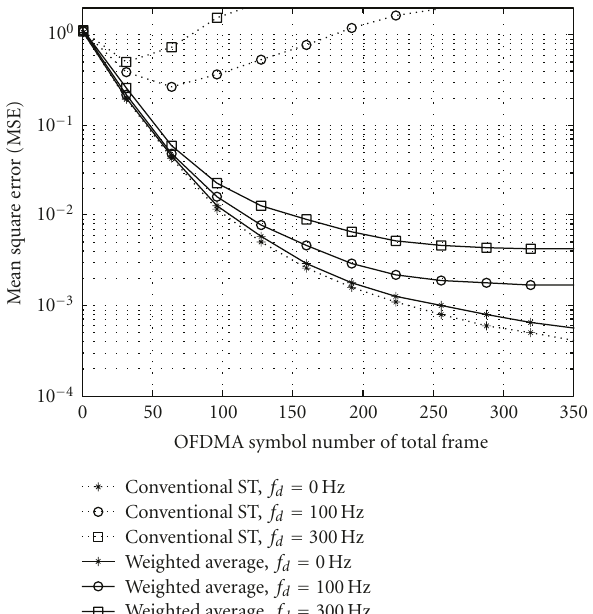
Figure 4: MSE versus frame length under the di ff erent Doppler frequencies, with Ω = 13 . 62 milliseconds, E p = 0 . 01E s , NL = 40, and SNR = 20dB.